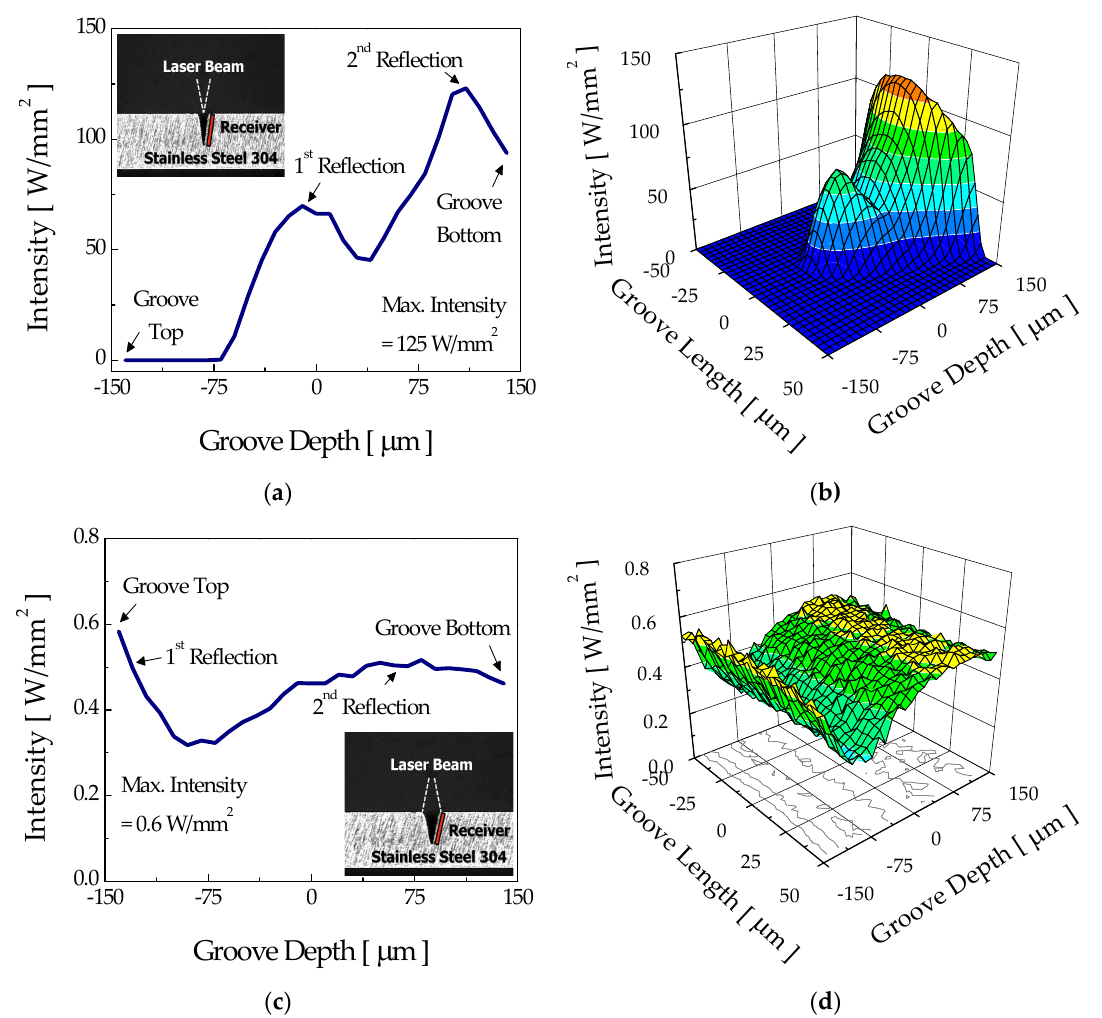
Figure 10. Sidewall intensity distributions of the fully developed V-groove which appeared in the ( a , b ) focusing mode and ( c , d ) diverging mode.